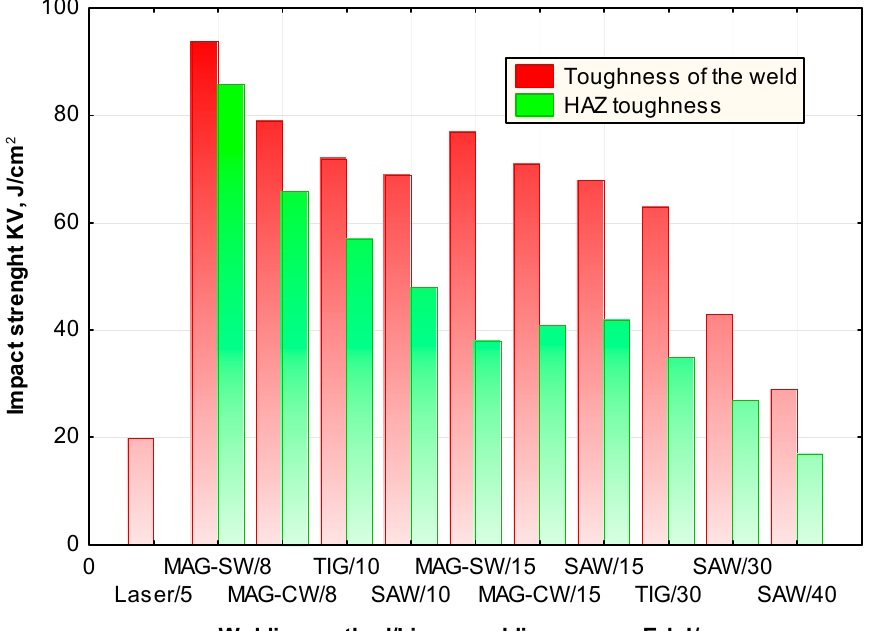
Figure 10. Effect of welding method and heat input on the toughness of the welded joints made of steel S700MC.